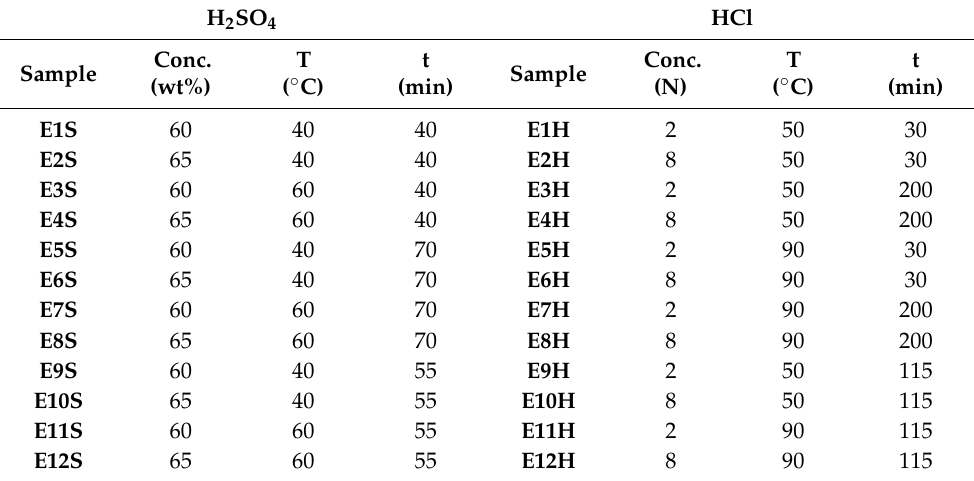
Table 2. Multilevel factorial design 2 3 process factors for CNC acid hydrolysis length